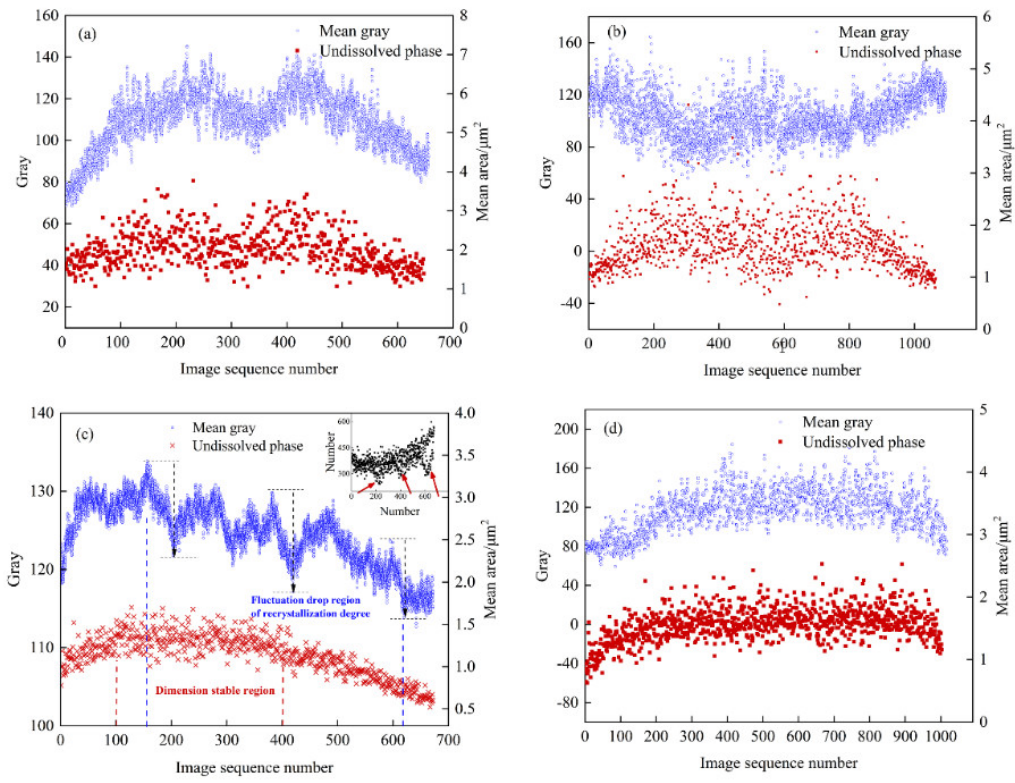
Figure 11. Distribution line diagram of gray and insoluble phases along the direction of section thickness in four aluminum alloys: ( a ) T4-6; ( b ) T4-15; ( c ) T5-10; ( d ) T5-15.